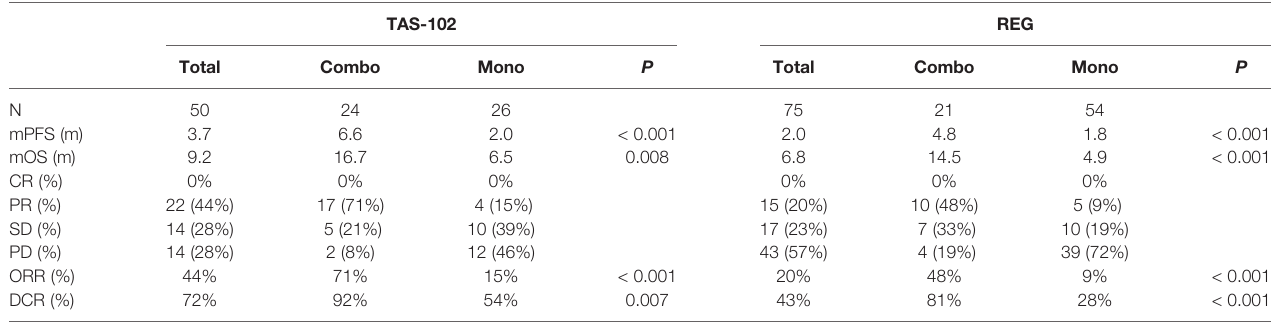
TABLE 2 | Oncologic outcomes of 125 patients with mCRC treated with TAS-102 and REG.